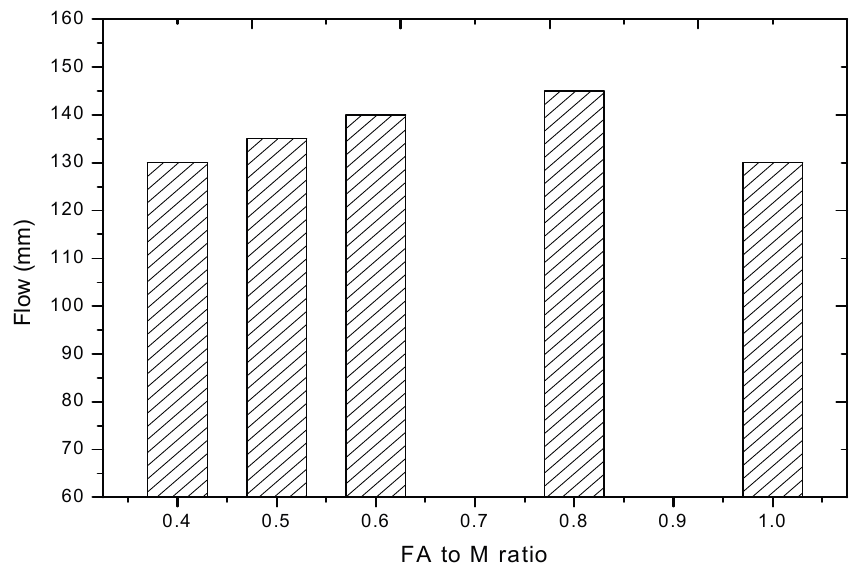
Figure 4. The effect of fly ash (FA) on the flow of MPC paste.